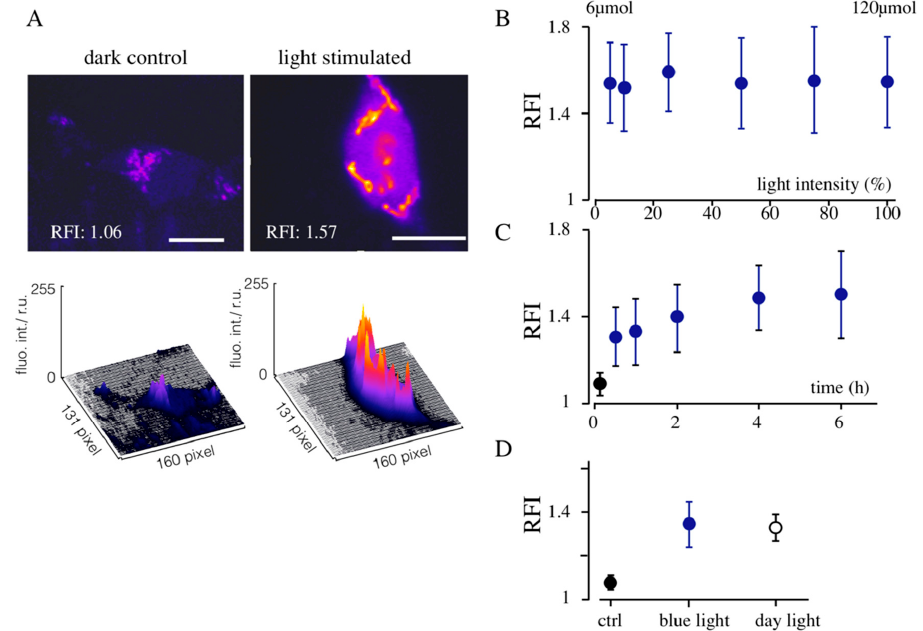
Figure 3. Light-triggered expression of Kesv. ( A ) Typical images of GFP fluorescence in HEK293 cells transfected with Kesv / CRY2 / CIB2. Images from cells kept in the dark (left column) and cells exposed for 1 h to 6 µ mol blue light (right column). To better compare the weak fluorescence of the control and the high fluorescence of illuminated cells, GFP fluorescence is presented in false color images. The reconstructed 3D surface plots in the second row report the corresponding fluorescent intensities. Relative quantification of the fluorescence (see the materials and methods) gives a relative fluorescence intensity (RFI) value of 1.06 and 1.57 for the dark control and the light-exposed cells, respectively. Scale bars: 10 µ m. ( B ) Mean RFI values ( ± SD) from HEK293 cells transfected with Kesv / CRY2 / CIB1 system. Cells were illuminated after transfection for 16 h with pulsed blue light (10 s on / 60 s o ff ) with light intensities ranging from 6 µ mol (5%) to 120 µ mol (100%). ( C ) Influence of the duration of illumination between 0 and 6 h on RFI value. Cells were illuminated with pulses (10 s on / 60 s o ff ) of 6 µ mol blue light. Cells were incubated after transfection for a total of 16 h. Illumination was in all cases ended 4 h prior to imaging. ( D ) Mean RFI values ( ± SD) from HEK293 cells expressing Kmpv 12T / CRY2 / CIB1. Cells were kept in the dark (ctrl) illuminated for 10 min with 450 nm blue light (6 µ mol) or kept in daylight for 10 min. In C and D, cells were incubated after transfection for a total of 16 h. Illumination was in all cases ended 4 h prior to imaging. Data are means ± standard deviation from 20